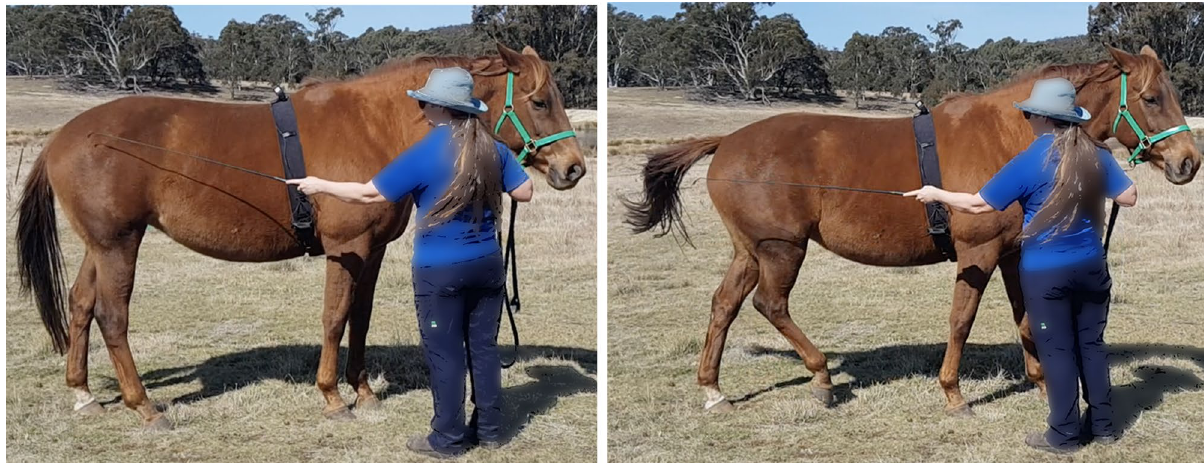
Figure 1. Learning task: Position of whip taps and reinforced response during learning task.